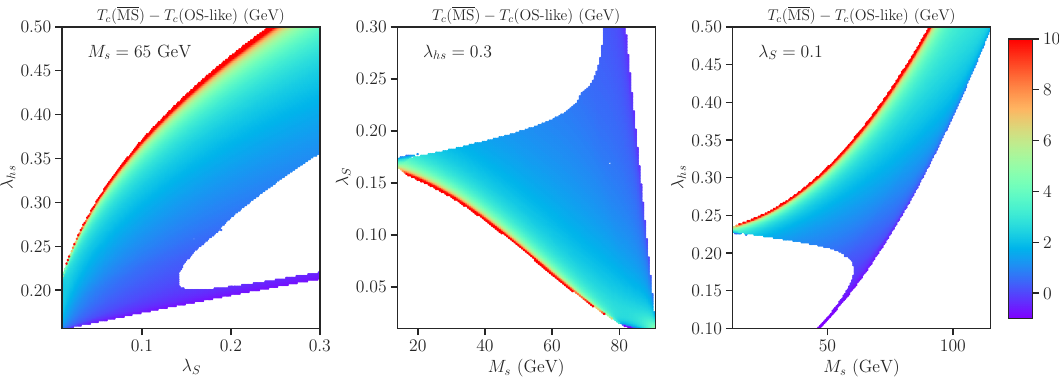
Figure 12 . The difference in critical temperature T c between the MS and OS-like schemes in 2-dimensional scans, under the same settings. In the blank regions there are no points with a FOPT in both the MS and OS-like schemes. We fix m = 62 . 5 GeV in the left panel, λ = 0 . 3 in the s hs middle panel, and λ = 0 . 1 in the right s